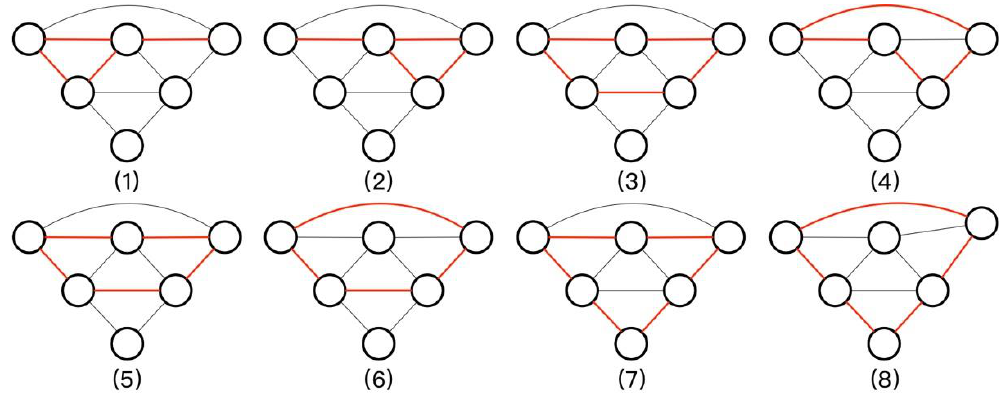
Figure 5. The 8 encoder-decoder structures in a basic 3-level Web-Net. The red lines in each graph constitute an independent encoder-decoder structure.